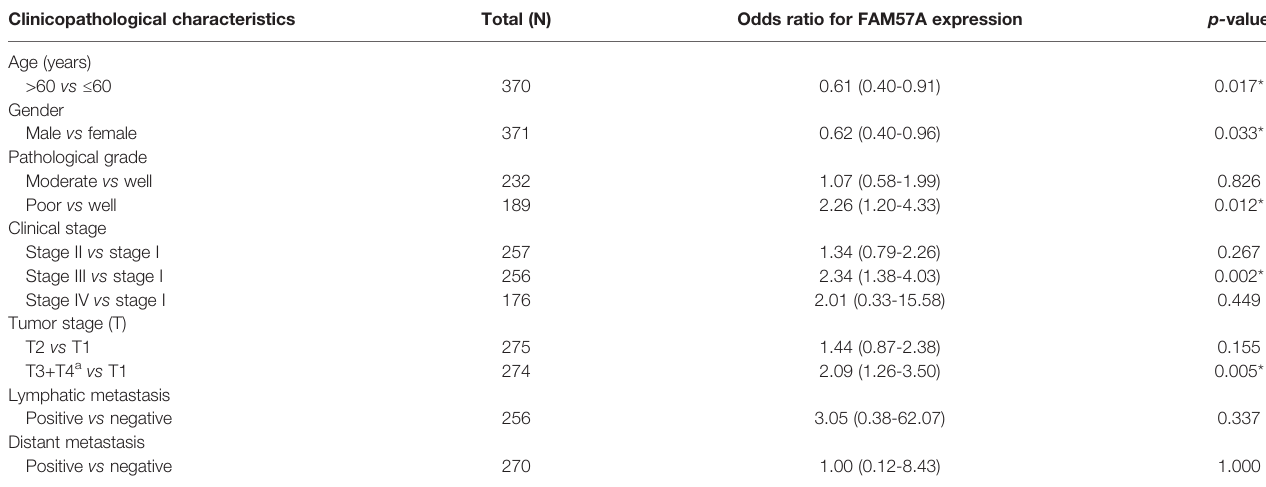
TABLE 1 | Association with FAM57A expression and clinicopathologic characteristics (logistic regression). Clinicopathological characteristics